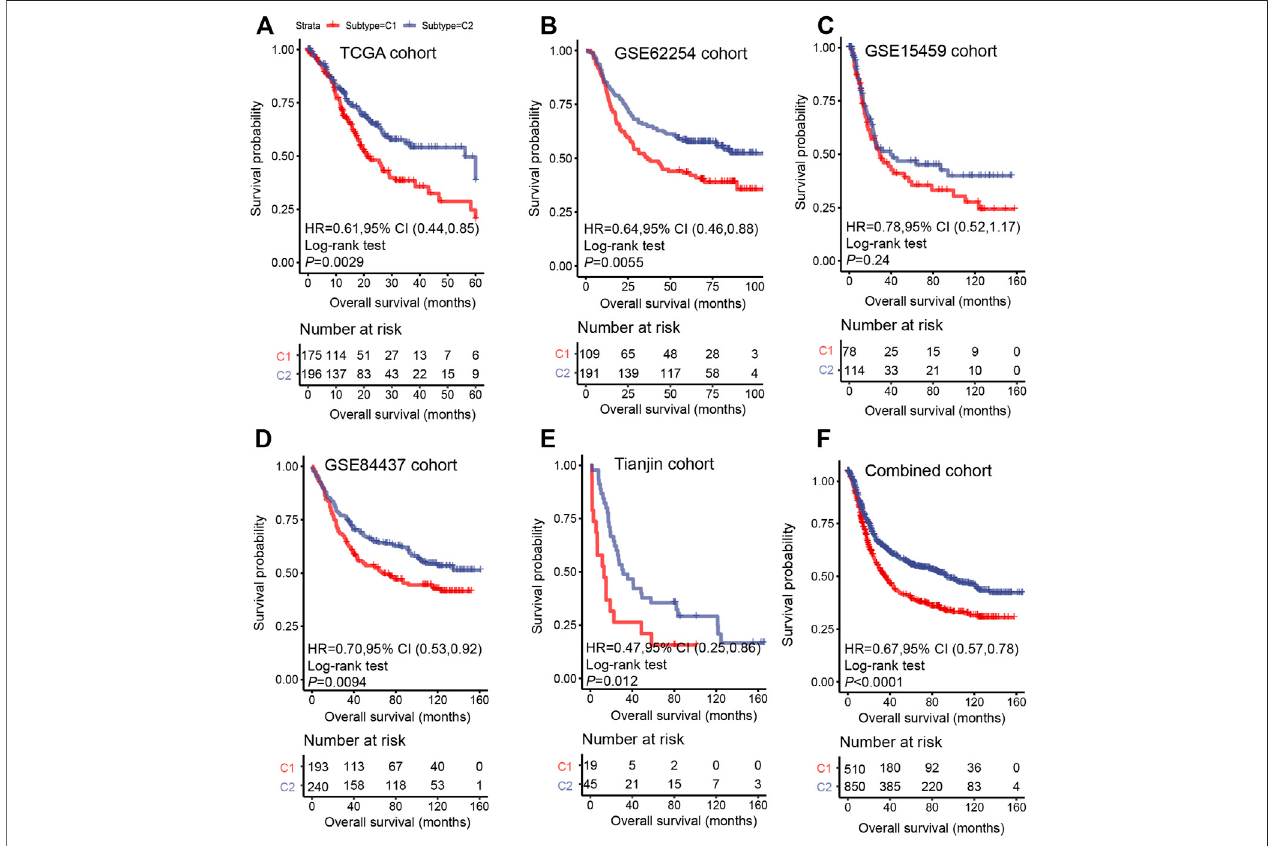
FIGURE3| SurvivalanalysisforC1/C2subtypein (A) TCGAcohort, (B) GSE62254cohort, (C) GSE15459cohort, (D) GSE84437cohort, (E) Tianjincohortand (F) CombinedcohortinC1/C2. Kaplan – Meierplotsofoverallsurvival(OS)amongpatients strati fi edbyC1/C2.Hazardratio(HR) wascalculatedbyCoxregressionanalysis. A p value was obtained using the log-rank